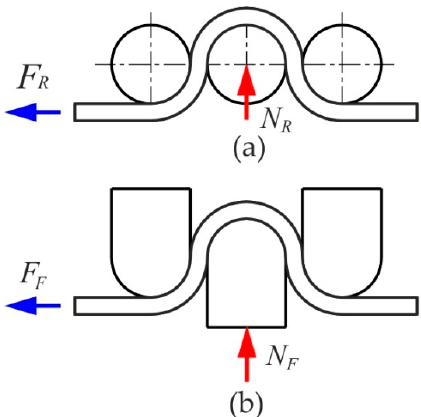
Figure 3. The concept behind the determination of frictional resistance: ( a ) rotatable rollers, ( b ) fixed rollers.